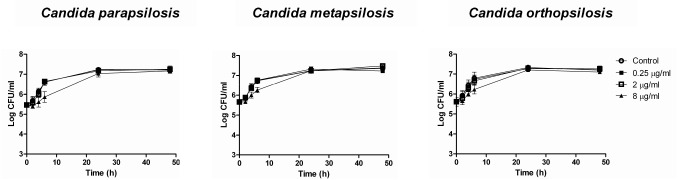
Mean TK curves from PAFE assays against 3 C parapsilosis sensu stricto, 2 C. metapsilosis and 2 C. orthopsilosis strains.Each data point represents the mean result ± standard deviation (error bars). Open circles (○): control; filled squares (■): 0.25 μg/ml; open squares (□): 2 μg/ml; filled triangles (▲): 8 μg/ml.